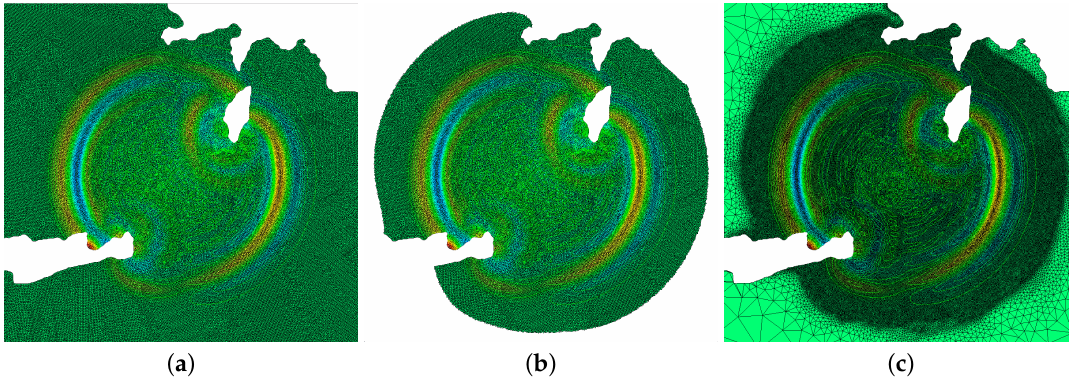
Figure 5. The mesh and the numerical isoline of the solution at t = 1000 s, with the full method at the left panel ( a ), the domain adaptive method at the center panel ( b ) and the FreeFem++ adaptation with err=1.e-7 at the right panel ( c